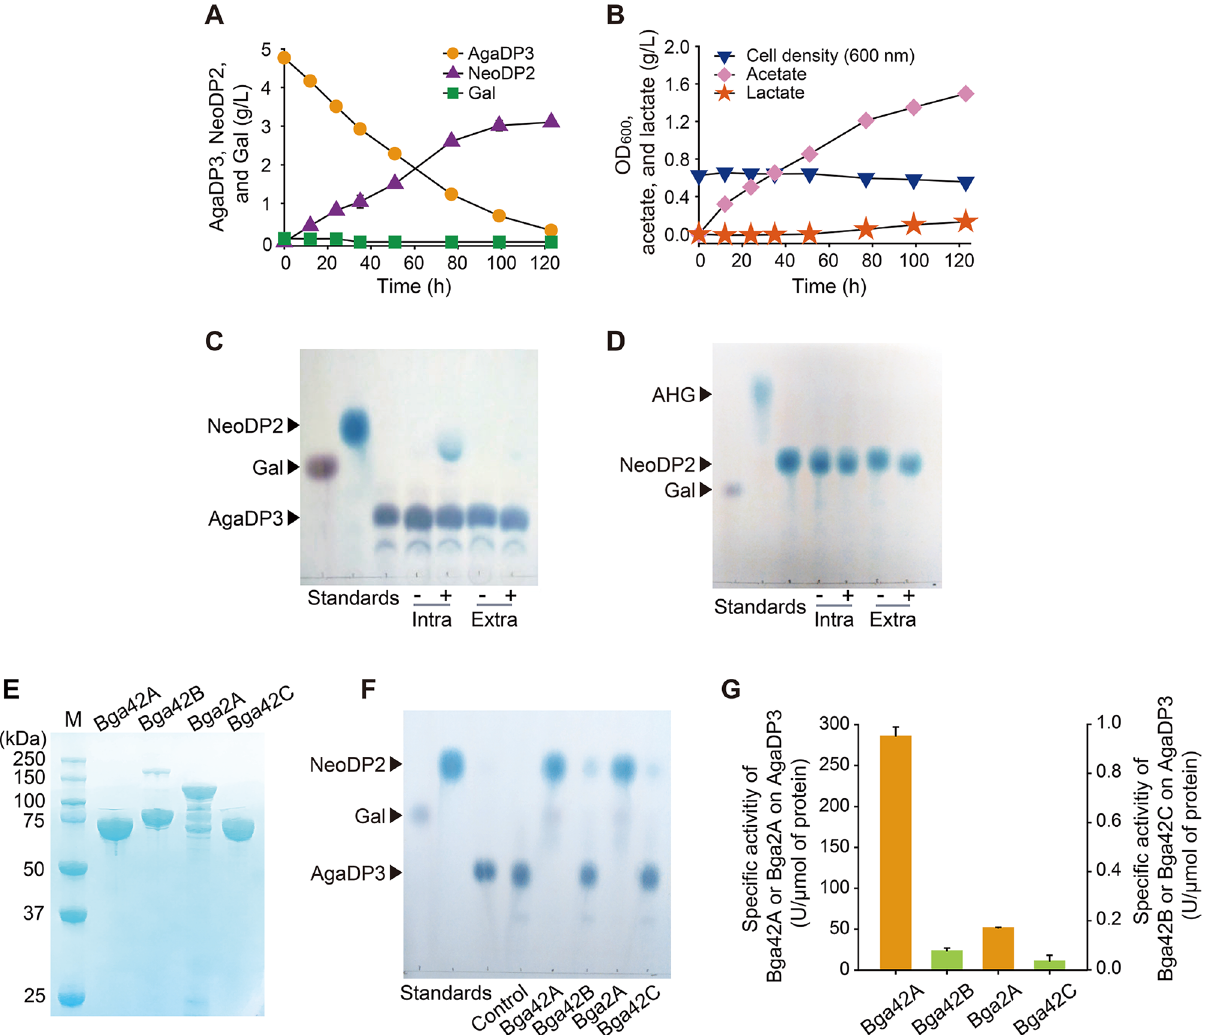
Figure 3. B . infantis extracts energy from AgaDP3 via its agarolytic β-galactosidase activity, and B. plebeius ultimately acts on NeoDP2, resulting in the production of AHG. ( A and B ) Time courses of AgaDP3 fermentation by B. infantis. Error bars mean ± S.D. ( C ) In vitro agarolytic β-galactosidase activities of extracellular crude enzymes (Extra) and cell-free lysate (Intra) obtained from B. infantis on AgaDP3. ( D ) In vitro NABH activities of extracellular crude enzymes (Extra) and cell-free lysate (Intra) obtained from B. infantis on AgaDP3. ( E ) SDS-PAGE analysis of the overexpressed and purified recombinant β-galactosidases Bga42A, Bga42B, Bga2A, and Bga42C originating from B. infantis . ( F ) TLC analysis of the reaction products of recombinant β-galactosidases from B. infantis —i.e., Bga42A, Bga42B, Bga2A, and Bga42C—with AgaDP3. ( G ) Comparison of the specific agarolytic β-galactosidase activities of the four β-galactosidases on AgaDP3. Error bars represent means ±